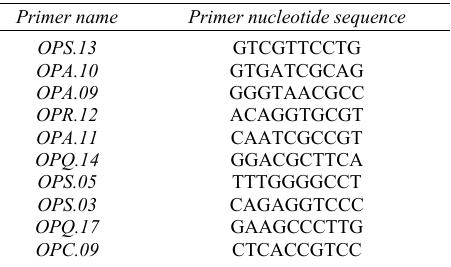
Table 1: Nucleotide sequence of RAPD-PCR primers